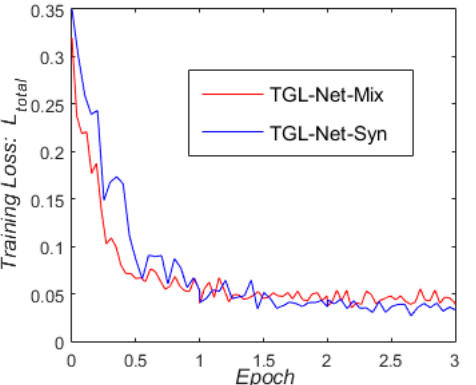
Figure 9. Loss curves for TGL-Net-Syn trained with only the synthetic set A, and TGL-Net-Mix trained with a combination of both the synthetic image set A and the real-world image set B.